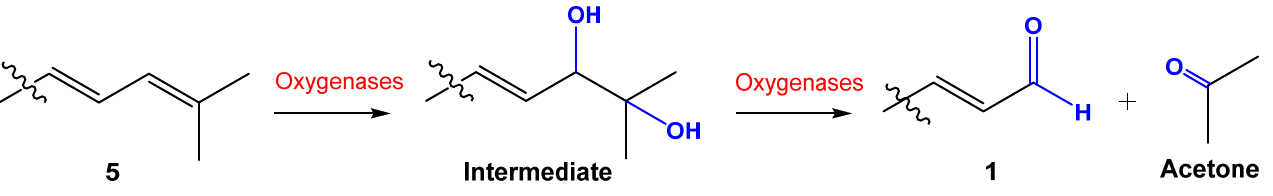
Figure 4. Hypothetic scheme of the biosynthesis of aglycon side chain of compound